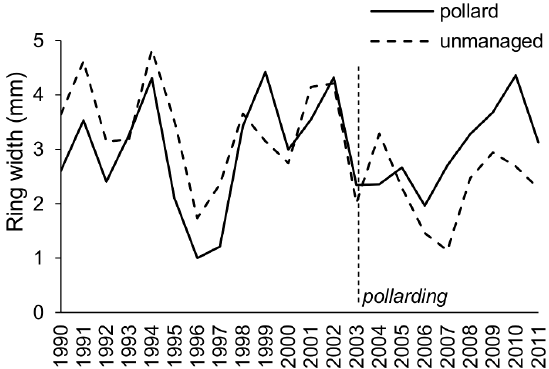
Figure 3. Radial growth of willows. Mean radial growth of pollards (solid line; n=8) and unmanaged willows (dashed line; n=10) at